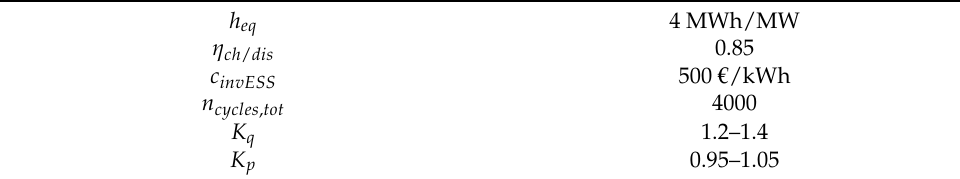
Table 2. Simulation